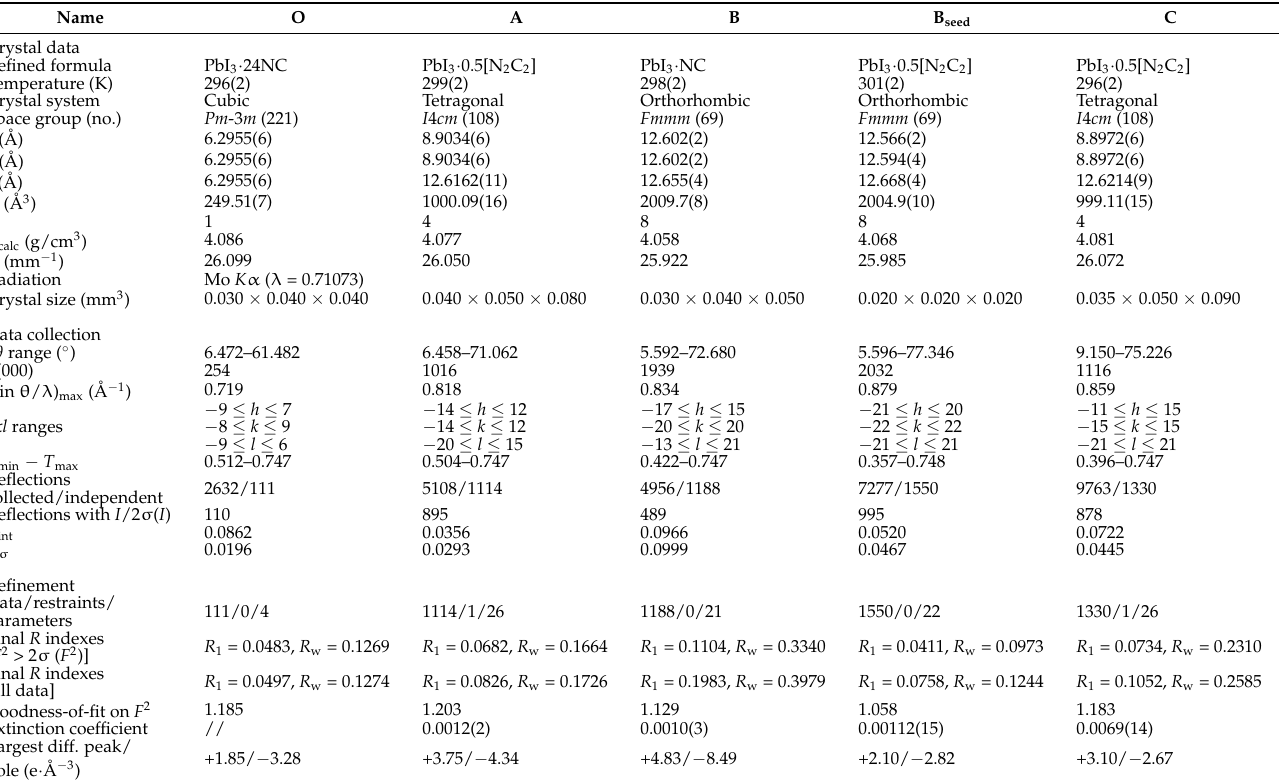
Table 1. Crystallographic data, experimental details and structure refinement parameters of MAPI crystals synthesized in GBL and acid